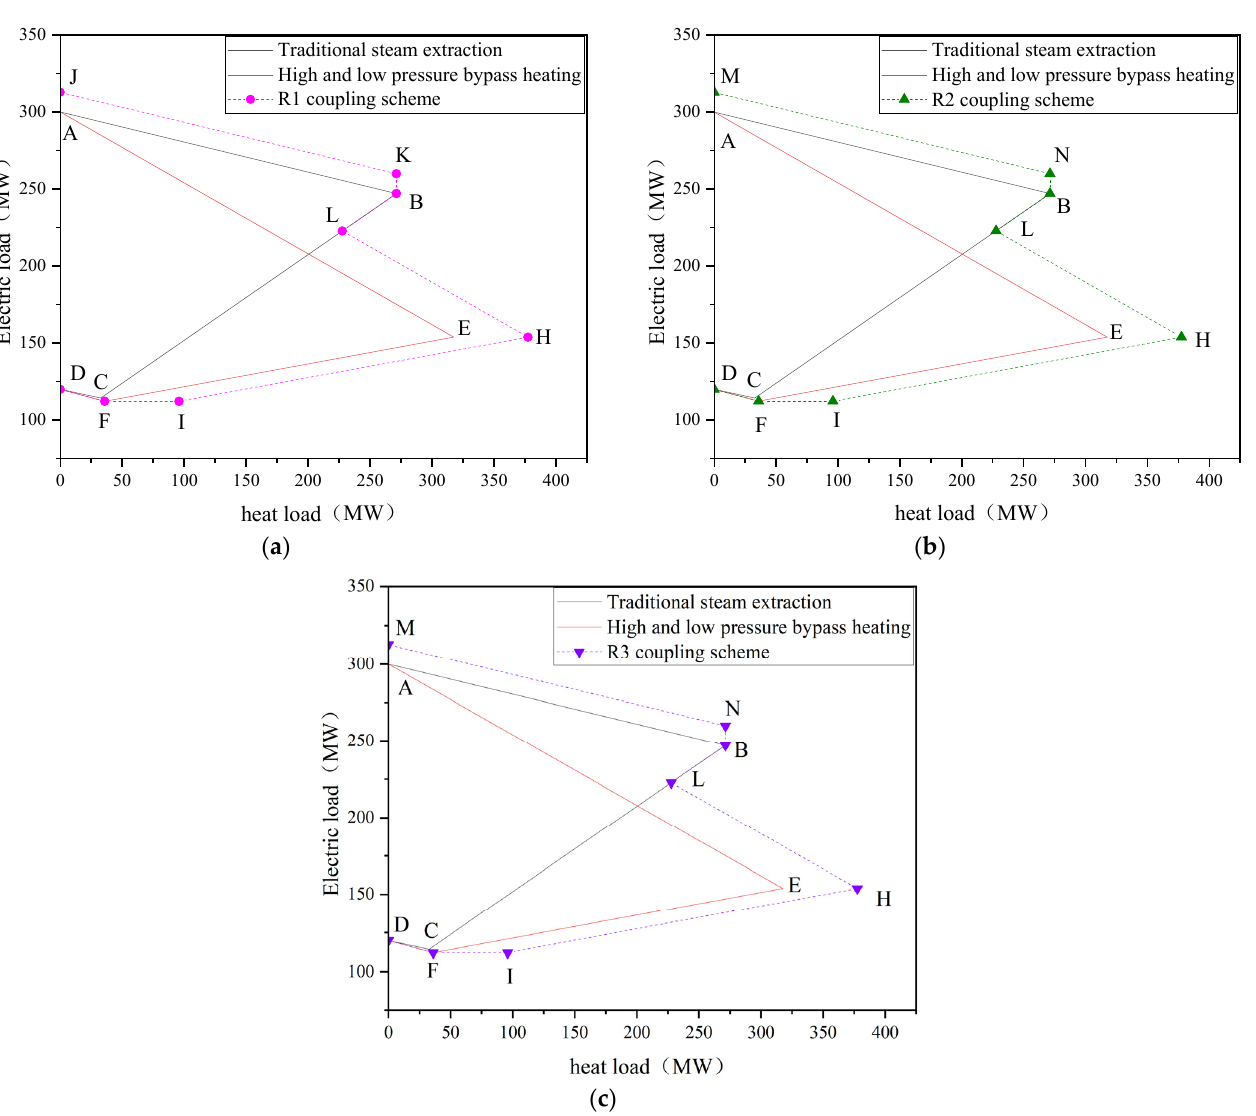
Figure 2. Electric heating characteristic diagram; ( a ) R1 ; ( b ) R2 ; ( c ) R3 .